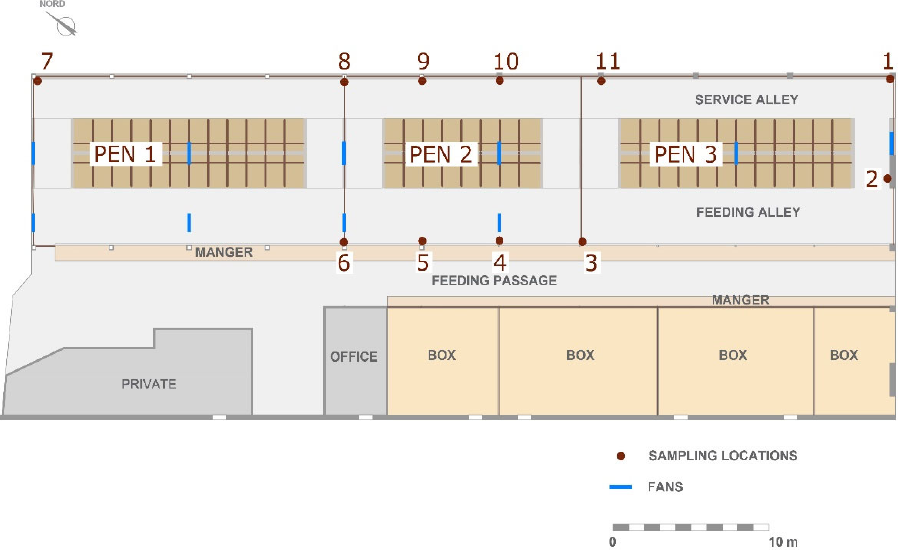
Figure 1. Plan view of the barn under study with the position of the sampling locations and